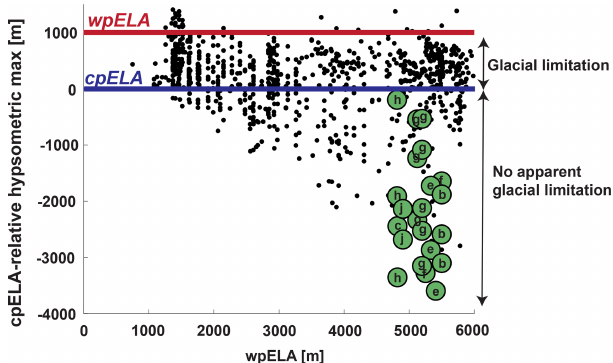
Figure 1. Hypsometric maximum of glaciated 1 ◦ × 1 ◦ SRTM tiles (adapted from Fig. 2 of Egholm et al., 2009, data provided courtesy of Vivi Pedersen). Each tile is plotted by its approximate warm- phase (modern) ELA (wpELA; x axis) and its hypsometric maxi- mum relative to (after subtraction by) the cold-phase ELA (cpELA; y axis); zero on the y axis therefore indicates a hypsometric maxi- mum at the cpELA. Glacial limitation is inferred for all SRTM tiles with a hypsometric maximum between the wpELA and cpELA. The tiles of tropical mountain ranges analyzed in this study are in green and labeled according to the scheme used in Figs. 3 and 8: (a) Leuser Range, Aceh (omitted here); (b) Central Range, Tai- wan; (c) Talamanca Range, Costa Rica; (d) Crocker Range, Borneo (omitted here); (e) Finisterre Range, Papua New Guinea; (f) Owen Stanley Range, Papua New Guinea; (g) Merauke Range, Papua; (h) Mérida Range, Venezuela; (i) Sierra Nevada de Santa Marta, Colombia (omitted here); (j) Rwenzori, East Africa. The Leuser Range, Crocker Range, and Sierra Nevada de Santa Marta were not included in the analysis by Egholm et al.